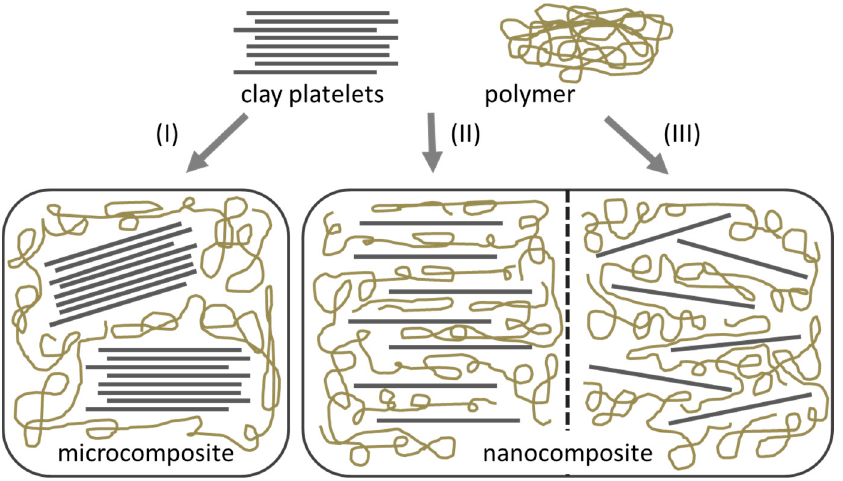
Figure 1. Different types of composites arising from the interaction of layered silicates and polymer. (I) Phase separated microcomposite, (II) intercalated nanocomposites and (III) exfoliated nanocomposites. Adapted from [31].